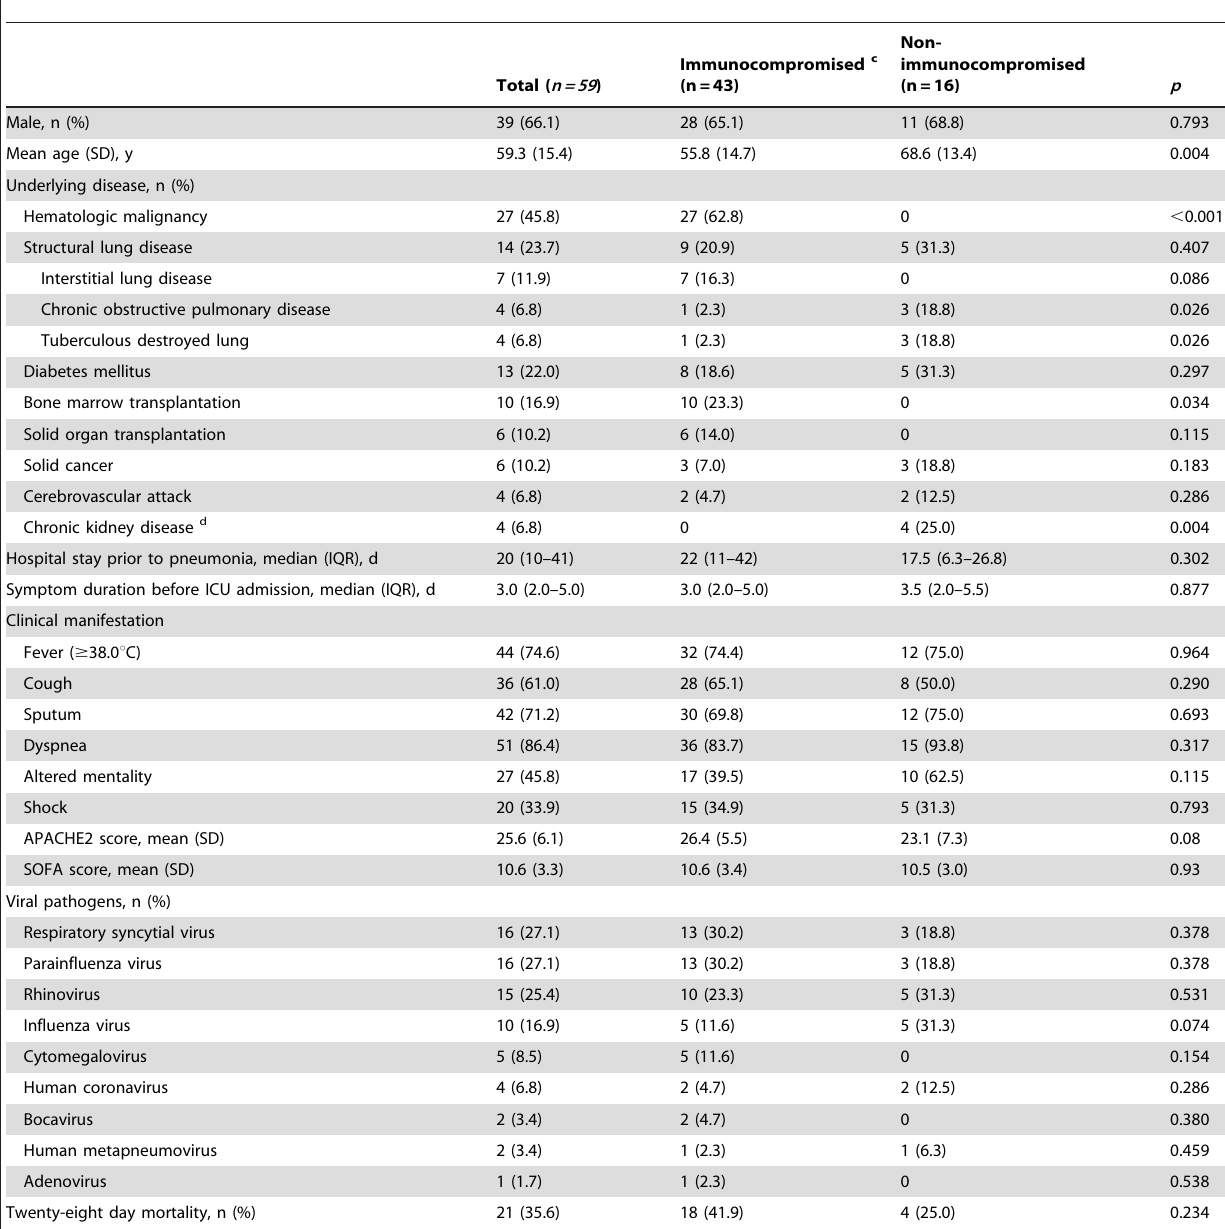
Table 4. Demographics, clinical characteristics, identity of pathogens, and outcomes of patients with severe pneumonia a,b